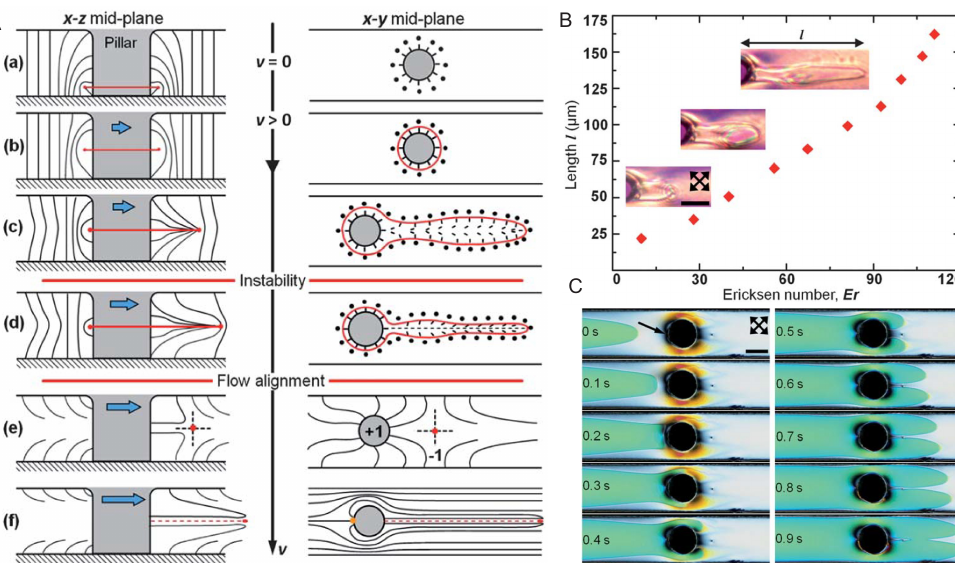
Figure 9. Nematic flow past a cylindrical barrier in nematic microchannel. ( A ) Morphological evolution of the defect structures in the presence of flow. Defects are drawn in red; black lines show the corresponding director. ( B ) Extension of the singular loop (measured between the pillar center and the leading end of the defect) shows a non-linear dependence with the Ericksen number Er. Insets show extension of the semi-integer defect loop with increasing the flow speed, observed between crossed-polarizers. Scale bar: 50 mm. ( C ) Time sequence of polarized micrographs representing the flow-alignment of the nematic director in microchannel. A distinct birefringent domain (green in appearance) with a parabolic boundary is observed upstream of the micro-pillar. The image is reprinted and adapted with permission from the reference [147]–Copyright (2013)